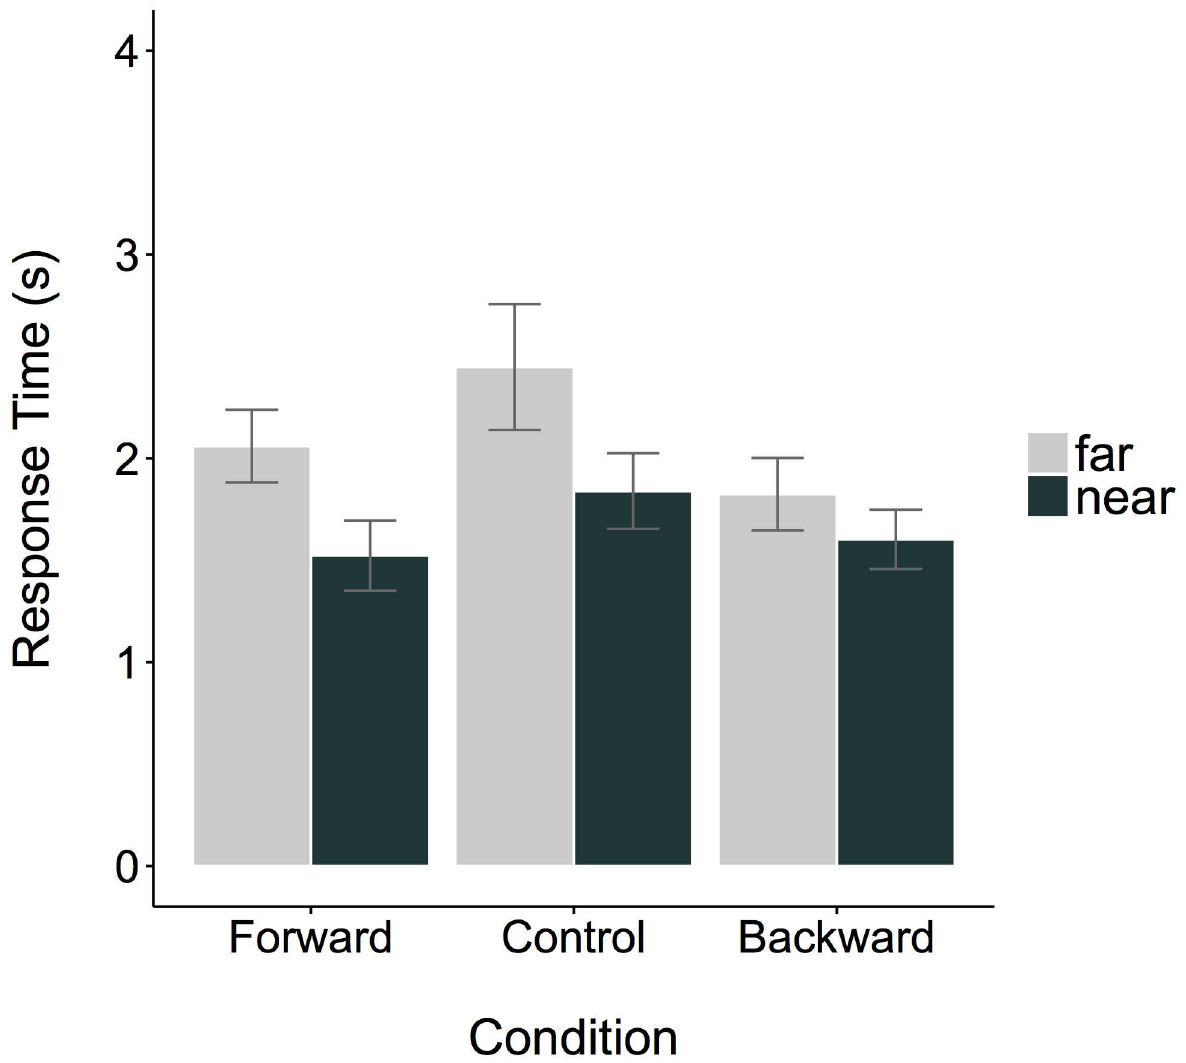
Fig 5. Mean response times (winsorized) to the ambiguous spatial question per condition and answer. Error bars represent standarderrors.